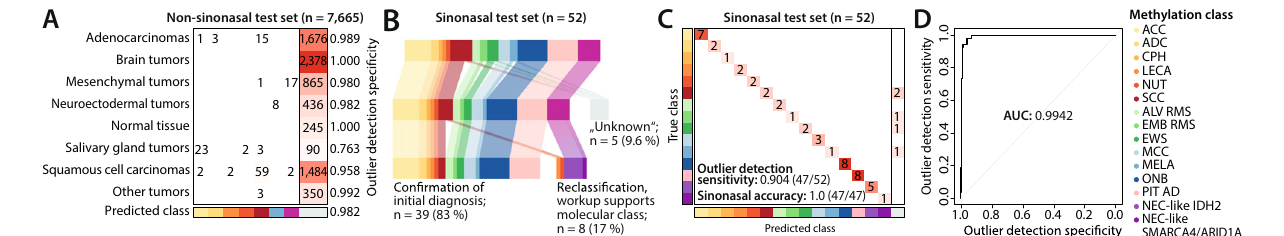
Fig. 5 | Classi fi er development and application to an independent test set. A Confusion matrix of the non-sinonasal samples from the test set, split up in different categories. Overall, the classi fi er achieved a speci fi city of 0.982, ranging from 0.763 in salivary gland tumors to 1.0 in normal tissue and brain tumors. B Overview of the classi fi cation results from the test set. Out of 52 samples, fi ve cases were assigned to the Unknown class, resulting in an outlier detection sensi- tivity of 0.904. Out of the 47 remaining specimens, DNA